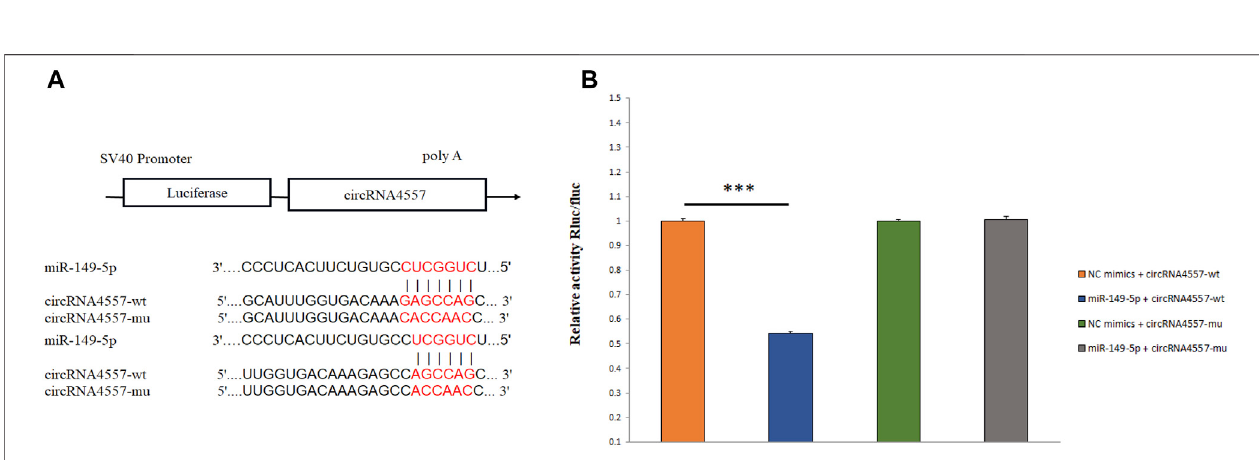
FIGURE 7 | Detection of targeting relationship by dual-luciferase reporter assay. (A) A schematic diagram of miR-149 binding to circRNA4557 target site; (B) Detection of the interaction between miR-149-5p and circRNA4557 by dual-luciferase reporter assay.